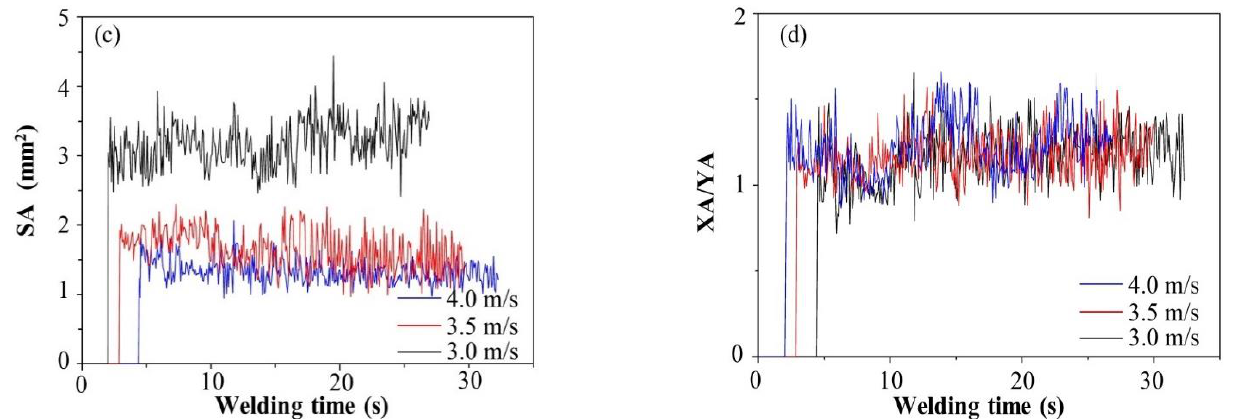
Figure 8. Characteristic parameters of keyhole exit under different welding speeds: ( a ) YA, ( b ) XA, ( c ) SA, ( d ) XA/YA.